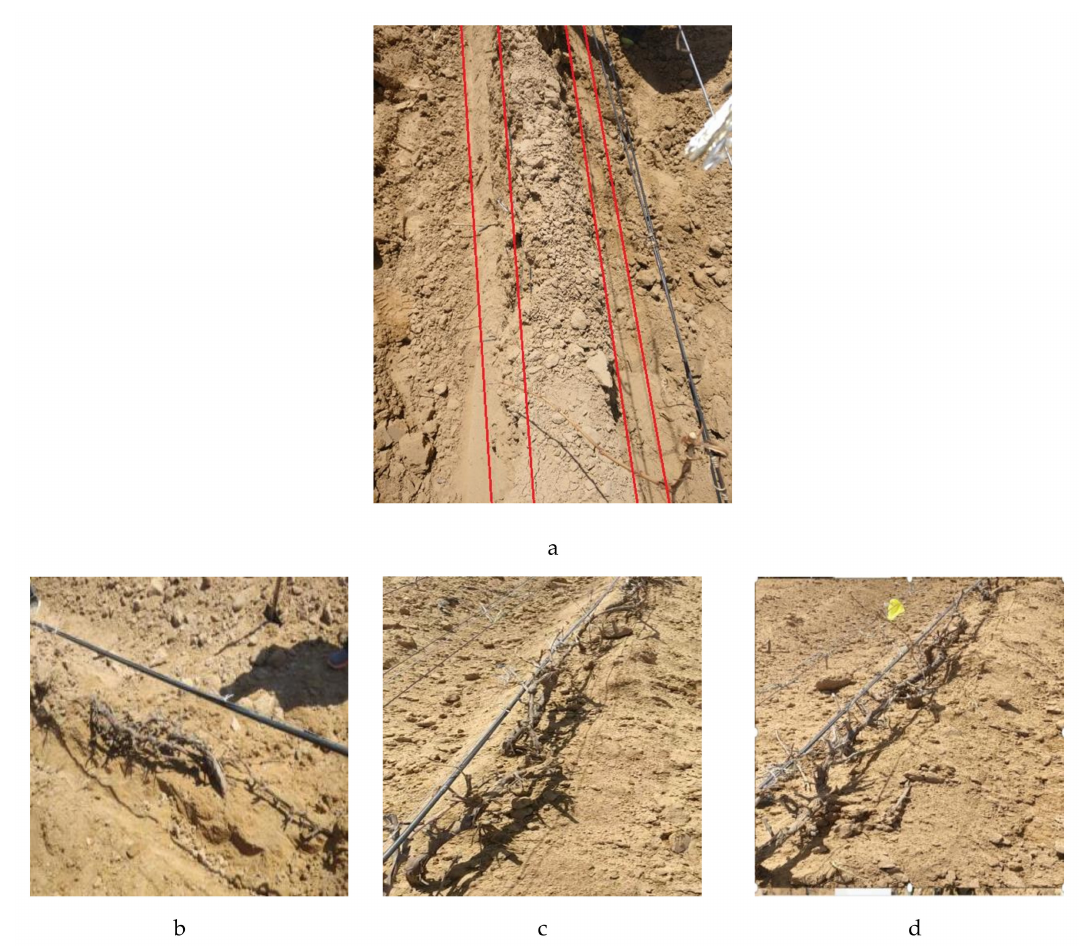
Figure 23. Soil cleaning effect. ( a ) the soil ridge when the scraper scrapes over, ( b ) experimental results without removing the hard tube, ( c , d ) experimental results with removing the hard